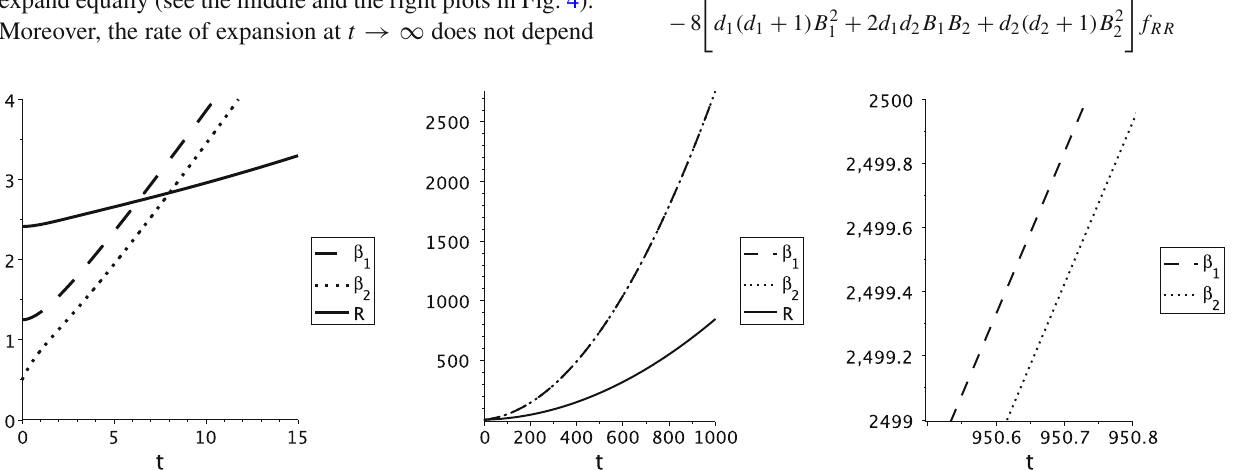
Fig. 4 The figures show the numerical solution of the system (4), (5) and (7) in various regions of time variation for d 1 = 3 , d 2 = 2 and